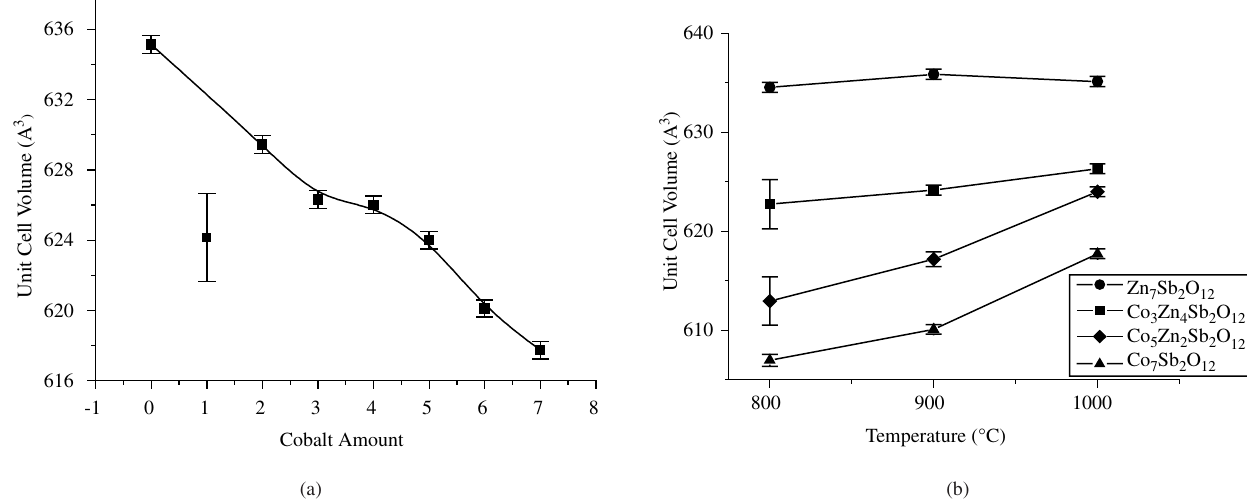
Figure 6. Unit cell volume results: a) Variation as a function of cobalt amount, after calcination at 1000° C; b) Variation as a function of temperature.